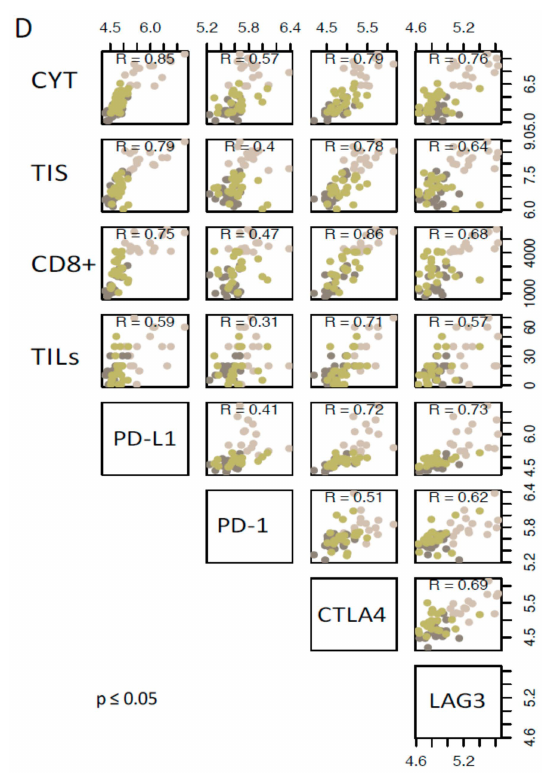
Figure 2. Local immune microenvironment and immuno-inhibitors portrait among the immune-clusters. Comparison of ( A ) Cytolitic activity score and ( B ) Tumor inflammation signature score values presented in boxplots. ( C ) Heatmap of gene expression of immune inhibitory molecules among the three immune clusters. Blue represent up-regulation while gray down-modulation. ( D ) Correlation matrix of local immune features and immune-inhibitory molecules across the Im-Clus, as measured by Spearman R coe ffi cients. CD8 + : ssGSEA enrichment score of activated CD8 t cells term; TILs: Pathological evaluation of the percentage of tumor infiltrating lymphocytes. All presented correlations are significant with p values ≤ 0.05. Statistical comparison based on Kruskal-Wallis